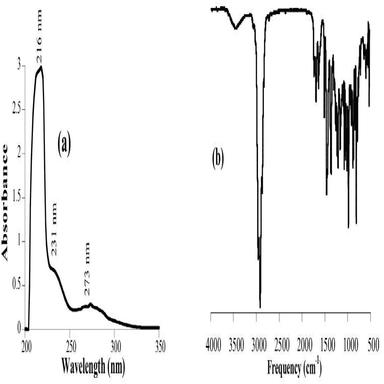
(a) UV–visible and (b) IR spectra of essential oil extracted from Eucalyptus globules.